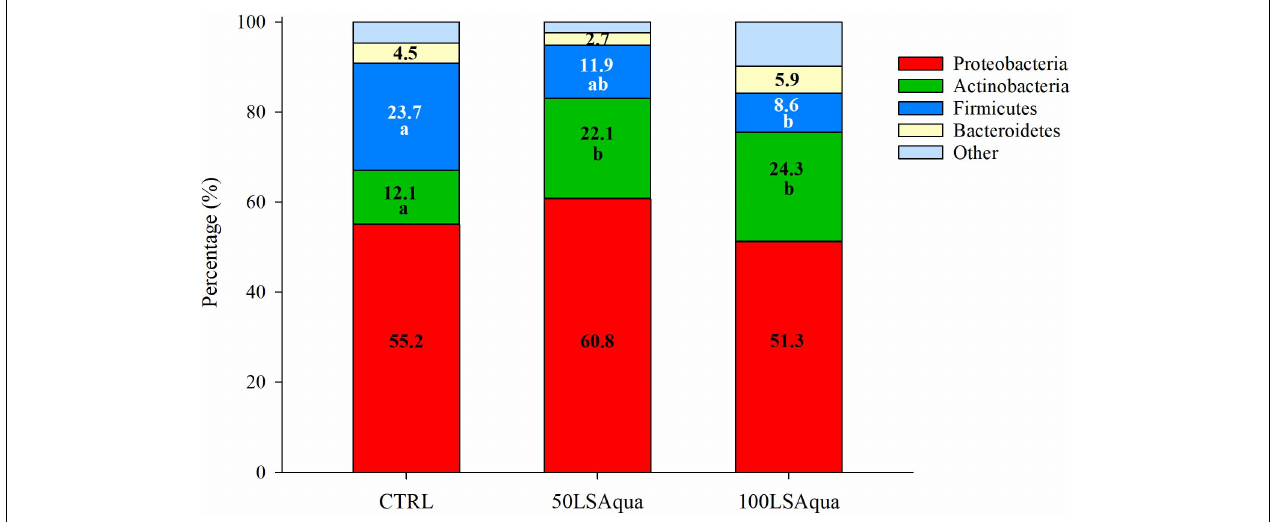
FIGURE 4 | Relative abundance of bacterial phyla in the anterior intestine of fish fed CTRL, 50LSAqua, and 100LSAqua diets. Significant differences (Kruskal–Wallis test, Dunn’s post-test, P < 0.05) are indicated by different letters which correspond to pairwise comparisons within each phylum among dietary